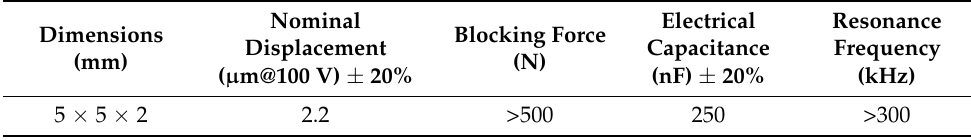
Table 1. Performance of multilayer piezoelectric ceramics